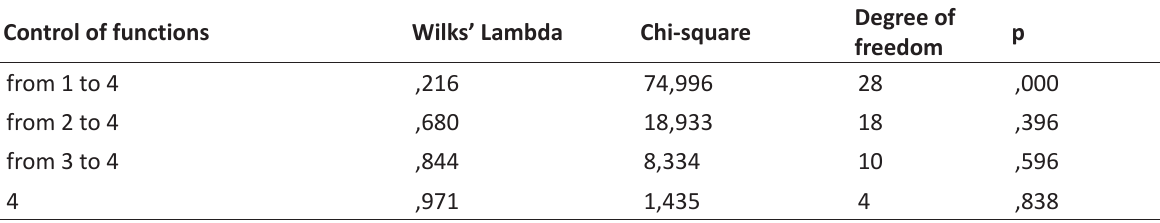
Table 4. Structural coefficients of canonical discriminant function. Boys aged 8 years old Content